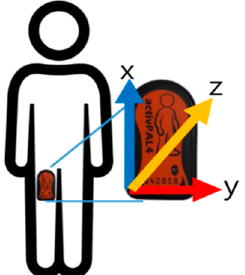
Figure 2. Sensor attachment position (middle of right thigh) and coordinate axis.